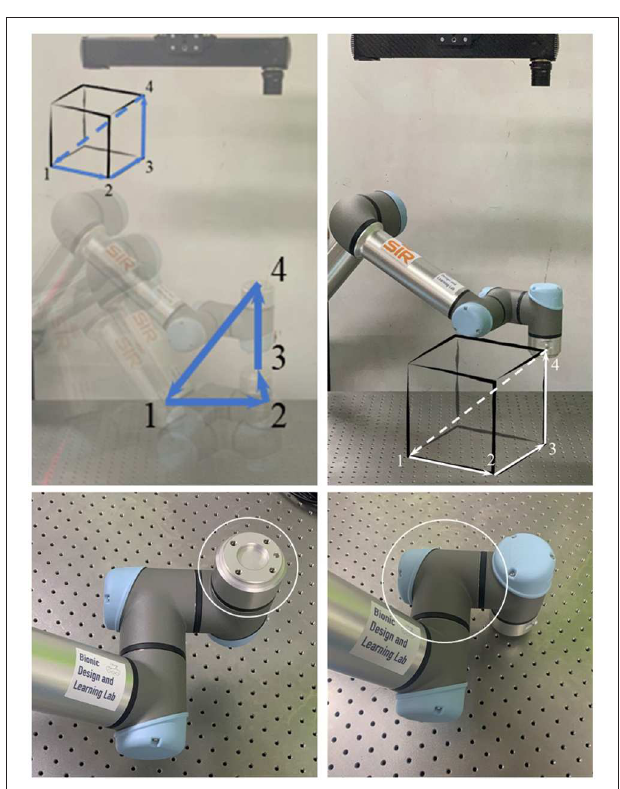
FIGURE 4 | Experiment setup using a minimum robot system, where the robot flange is configured to move along four way points on the vertices of a cube.